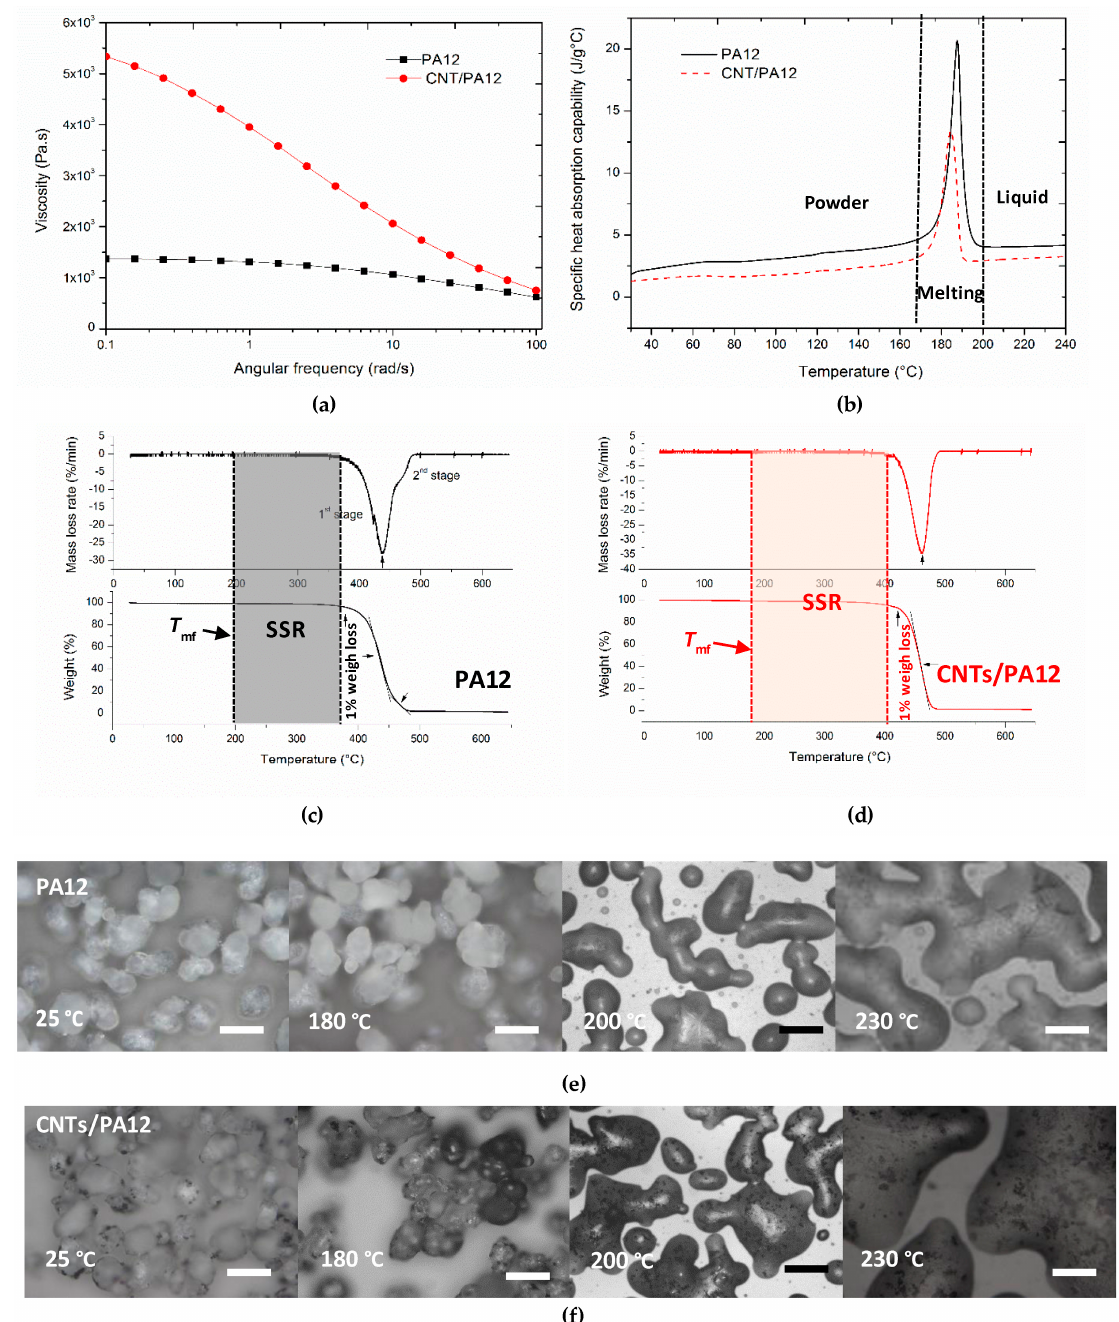
Figure 4. ( a ) melt viscosity of PA12 and CNTs/PA12 at 200 °C; ( b ) specific heat absorption of PA12 and CNTs/PA12 over the process temperature range; ( c , d ) TGA plots of decomposition processes of PA12 and CNTs/PA12, respectively; ( e , f ) the optical images of the fusion process of PA12 and PA12/CNTs powders (the scale bars are 100 µm).